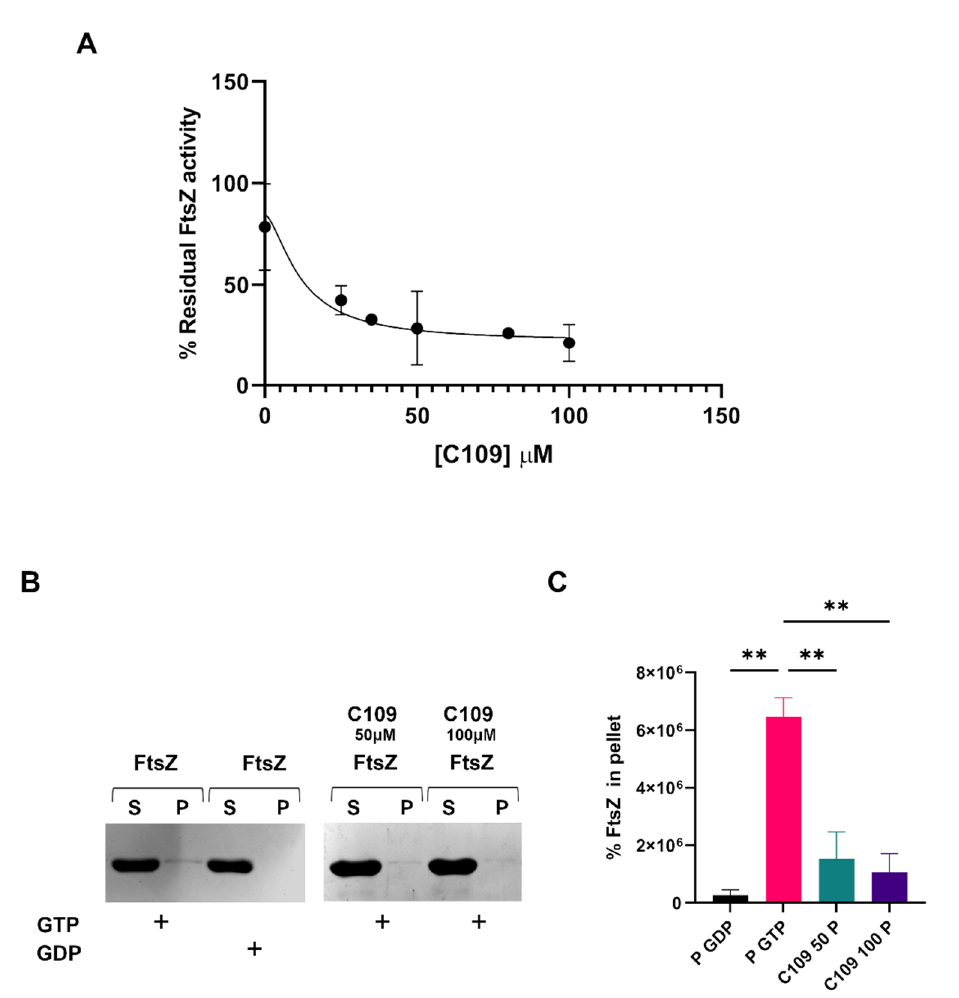
Figure 7. GTPase activity and polymerization assays on A. baumannii FtsZ in the presence of C109. ( A ) IC 50 of C109 against A. baumannii FtsZ. ( B ) Sedimentation assay of FtsZ in the presence, or absence, of C109, GTP and GDP. P, insoluble fraction (pellet); S, soluble fraction (supernatant). ( C ) Relative quantification of FtsZ percentage in the pellet of the indicated samples obtained by densitometry analysis. Data are the mean ± SD of the results from three different replicates; images are representative of at least three different experiments . ** p < 0.01 (one ‐ way ANOVA test).